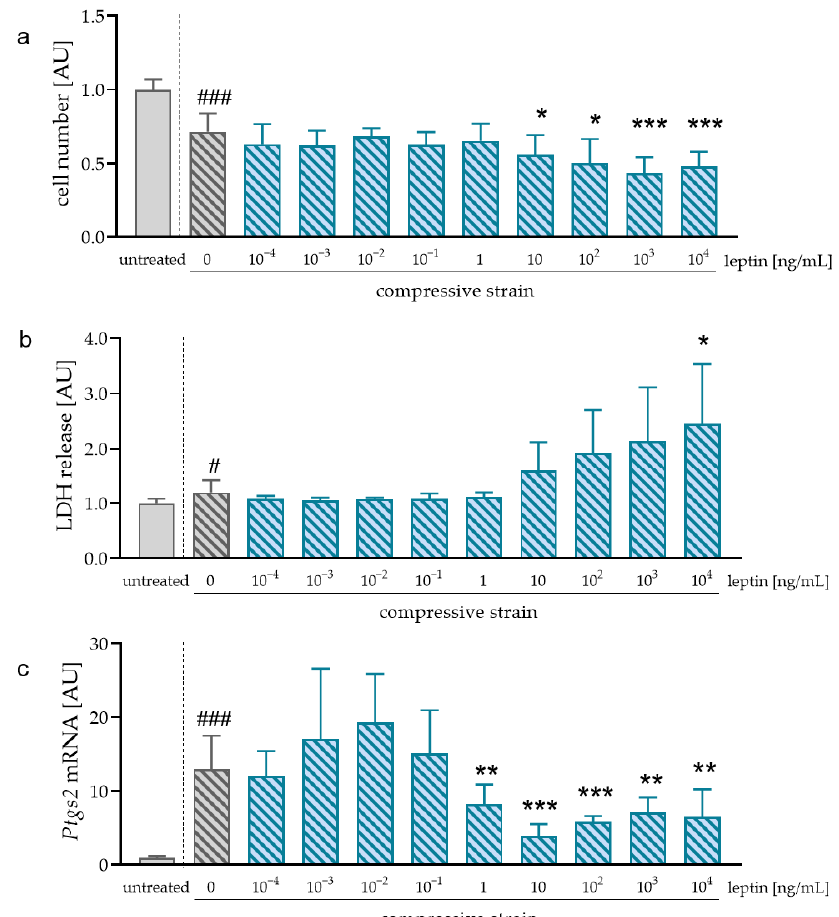
Figure 3. Cell number ( a ), LDH release ( b ) and Ptgs2 gene expression ( c ) after treatment of RAW264.7 macrophages with different leptin concentrations. n > 5; Statistics: ANOVA followed by unpaired t tests with Welch-correction. # p < 0.05; ### p < 0.001 compared to untreated control; * p < 0.05; ** p < 0.01; *** p < 0.001 compared to 0 ng/mL leptin and compressive strain.